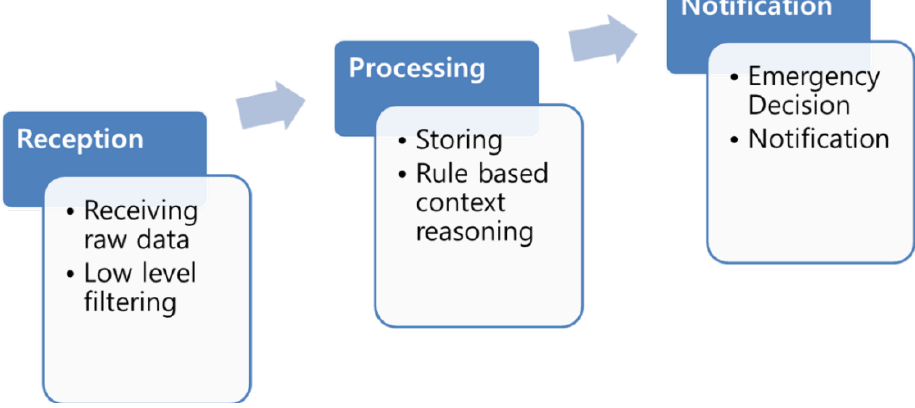
Figure 7. Context awareness is defined as receiving the raw data from the sensor, filter them and then process them based on the rules to detect the fire symptom and then notify the users and other parts of the system like